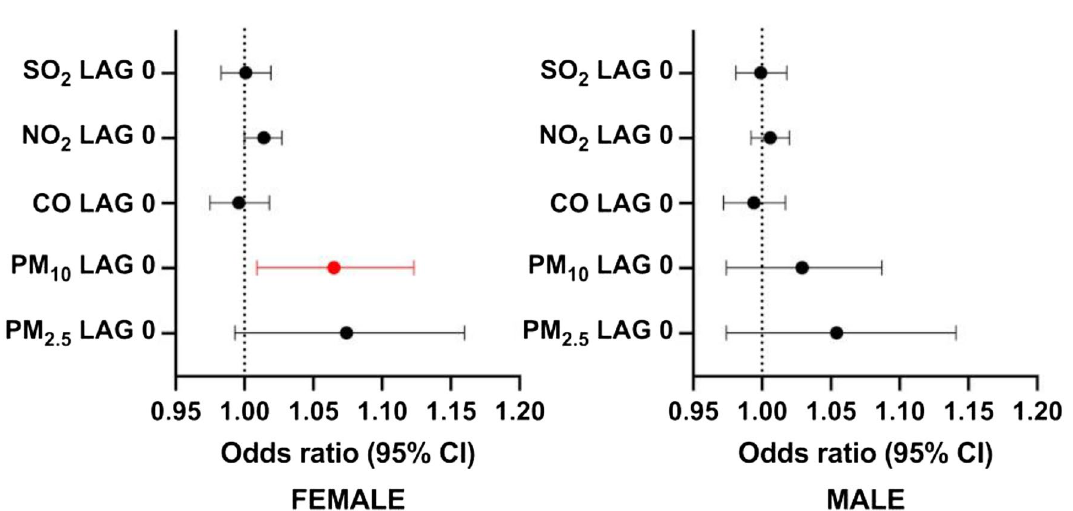
Figure 3. Associations between the exposure to short-term pollutants and ischemic stroke incidence in the study group divided by